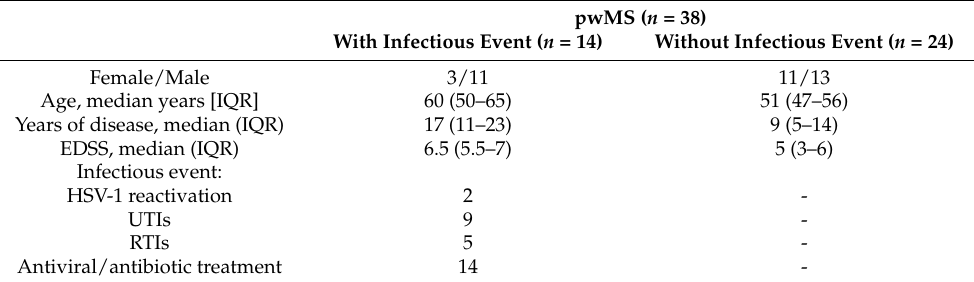
Table 3. Clinical and demographic features of pwMS stratified according to the occurrence of infectious event.